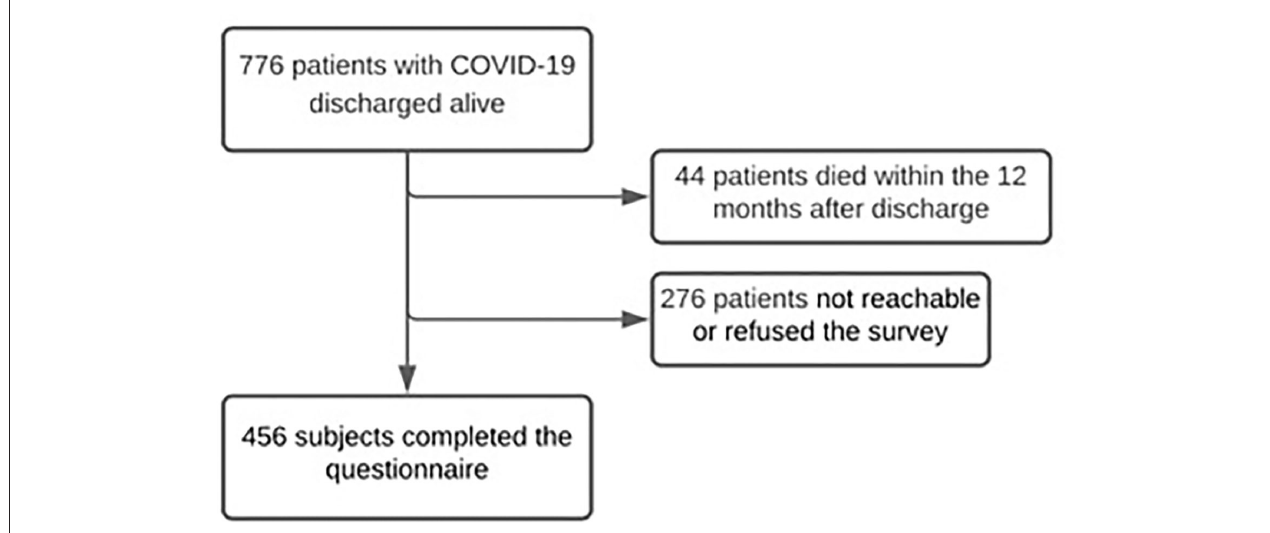
FIGURE 1 | Flow chart of patients with COVID-19 discharged between the pandemic beginning and May 31st,